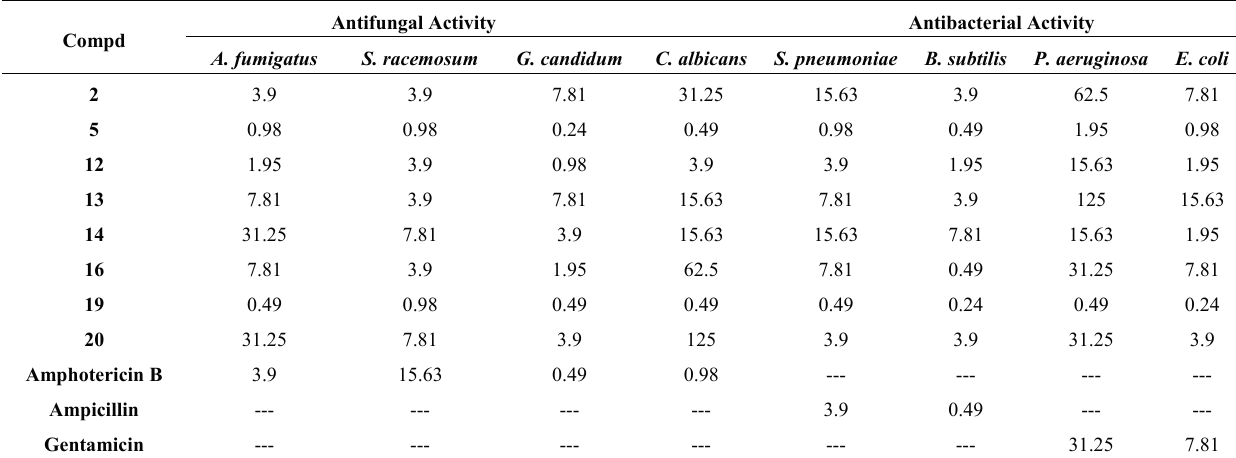
Table 3. Antimicrobial activity expressed as MIC ( μ